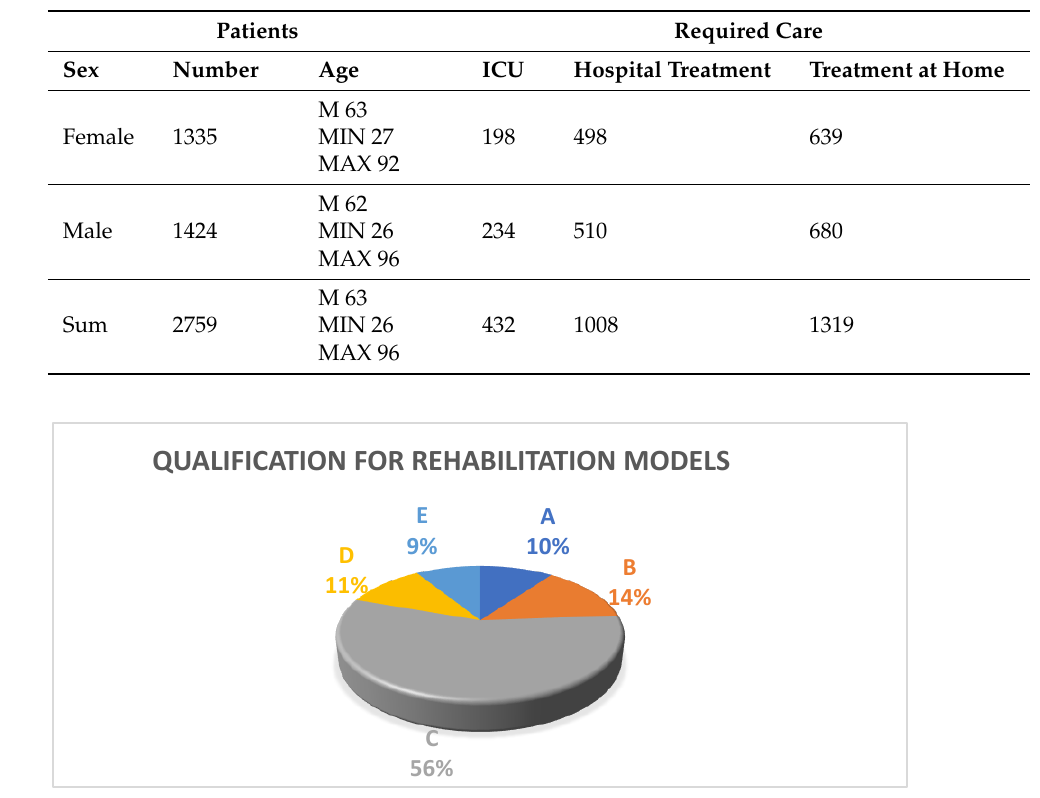
Figure 1. Qualification for five models of rehabilitation (A – E) in the period of 1 September 2020 – 17 June 2022.